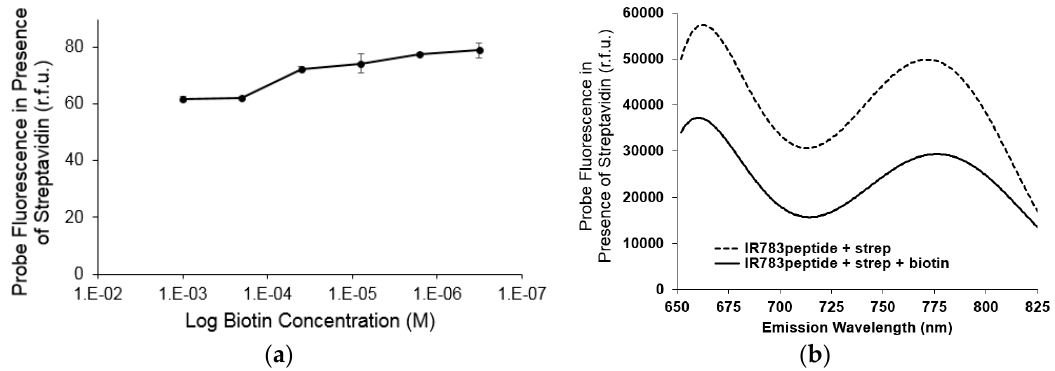
Figure 5. The biotin mimetic probe IR-783 VSHPQAPF, when bound to streptavidin, has enhanced fluorescence, which is reversible when native biotin is subsequently added to competitively elute the probe from the streptavidin target: ( a ) Addition of increasing amount of biotin shows a significant decrease in fluorescence when more than one equivalent of biotin was combined with respect to the streptavidin concentration; ( b ) Fluorescence spectra show that the addition of 3 equivalents of biotin results in a decrease in intensity of the signal but no significant peak shift.